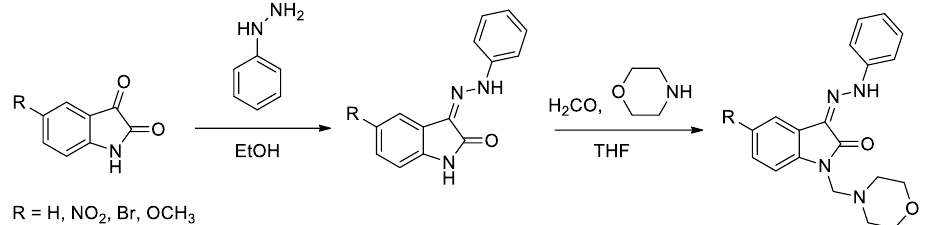
Figure 1. Reaction scheme for obtaining 3-(phenylhydrazono)isatin with a methylmorpholine sub- stituent in the N-1 position.